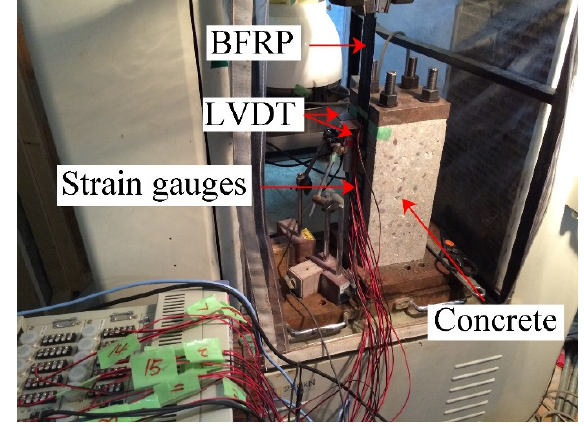
Figure 2. Detailed test setup of the single-lap shear test.